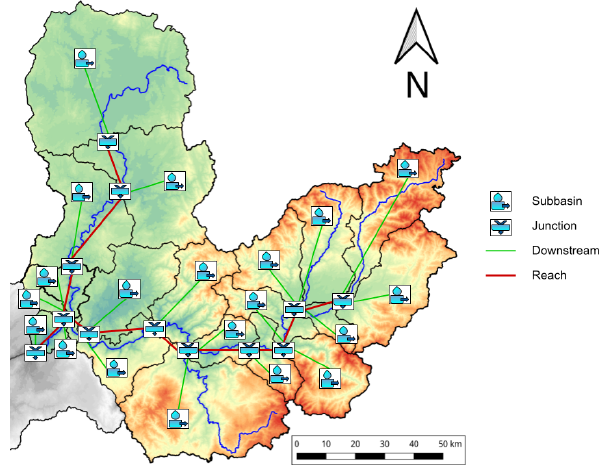
Figure 3. Map with the hydrological characterization of the basin under the scope attending to its topographical features. Subbasin refers to the divisions of the basin under scope, Junction refers to the points in the flow network where multiple inflows combine, Down- stream refers to the point in the main river channel where each sub- basin flows, and Reach represents the main river